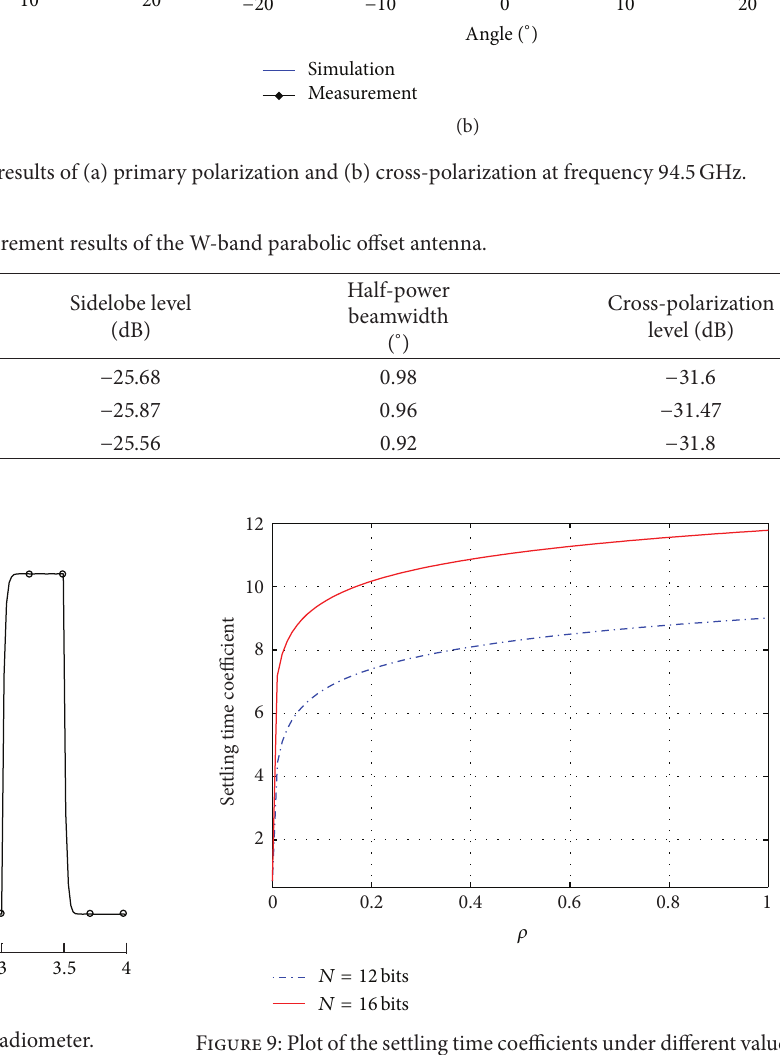
about 9 and 11.8 times of the time constant, respectively, with a voltage step of the ADC full-scale